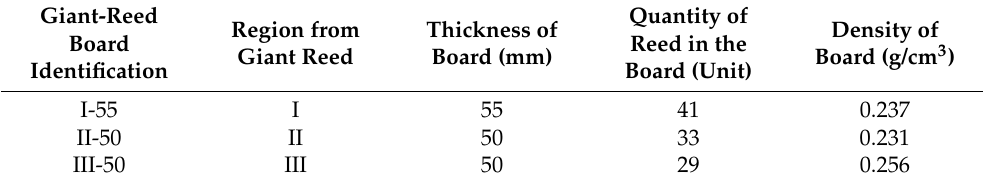
Table 2. Identification and main characteristics of giant-reed boards from Regions I, II and